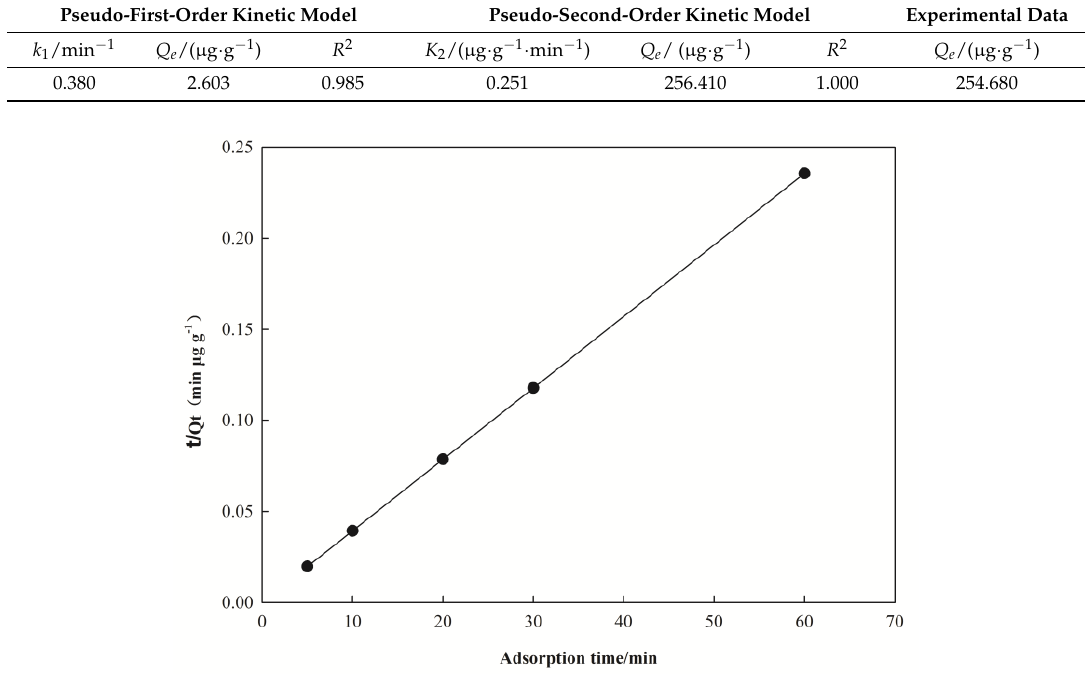
Figure 4. Pseudo-second-order plots for the adsorption of Pb(II) at 298 K.